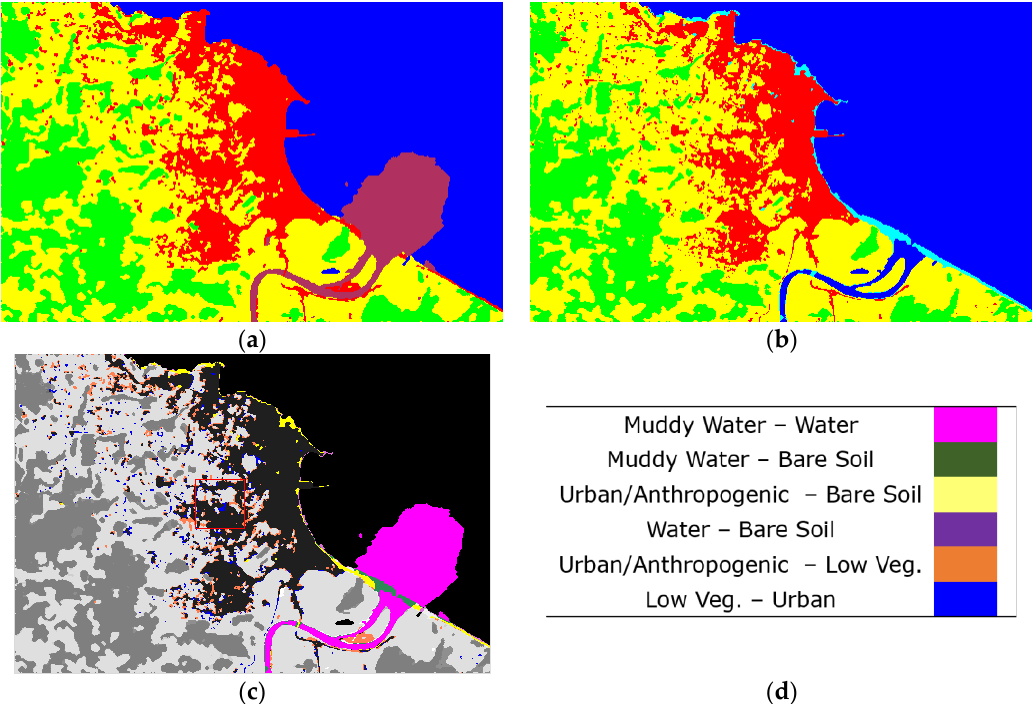
Figure 7. Experimental results obtained on the “Jérémie 2016” and “Jérémie 2017” datasets: ( a ) classification map corre- sponding to 2016; ( b ) classification map corresponding to 2017; ( c ) change map specifying the changes occurring between 2016 and 2017; ( d ) legend representing the class transitions in the change map. For the legend of the classification maps, we refer to Table 1.